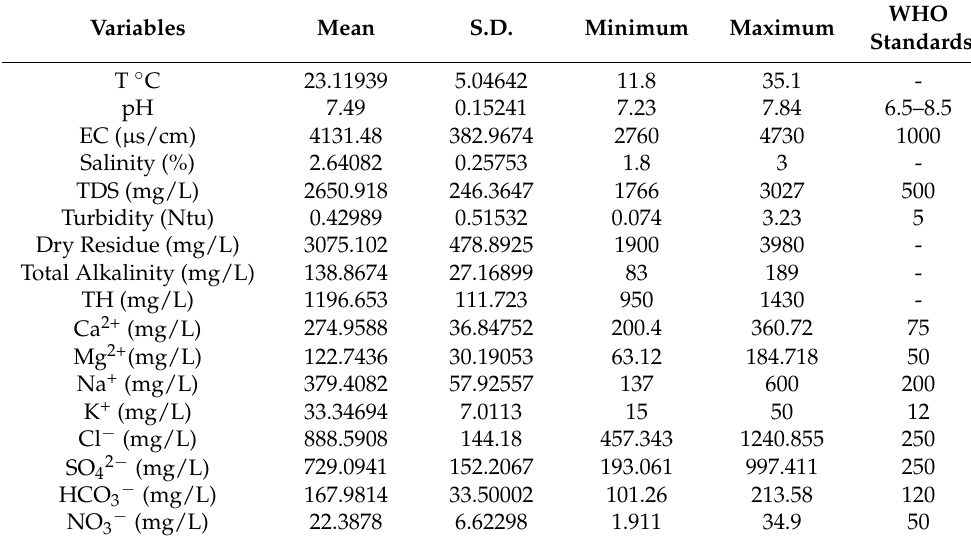
Table 1. List of the physicochemical parameters evaluated and calculated in groundwater samples.